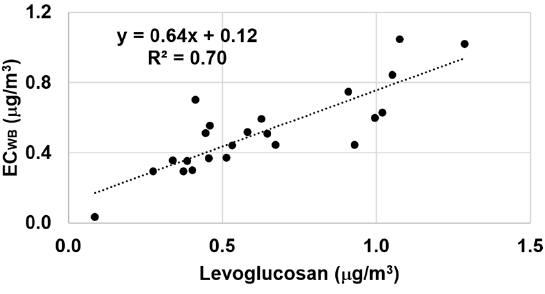
Figure 9. EC WB vs. levoglucosan scatterplot for samples with ABS (375nm) < 0.9. Multiple linear regression for OC source apportionment (Section 2.4.4) on Milan dataset resulted in k 1 = 0.33 ± 0.05, k 2 = 0.34 ± 0.07, and OC NC =1.1 ± 1.0, where uncertainties are the standard error of the regression. It is noteworthy that OC NC is comparable to zero within 2 standard